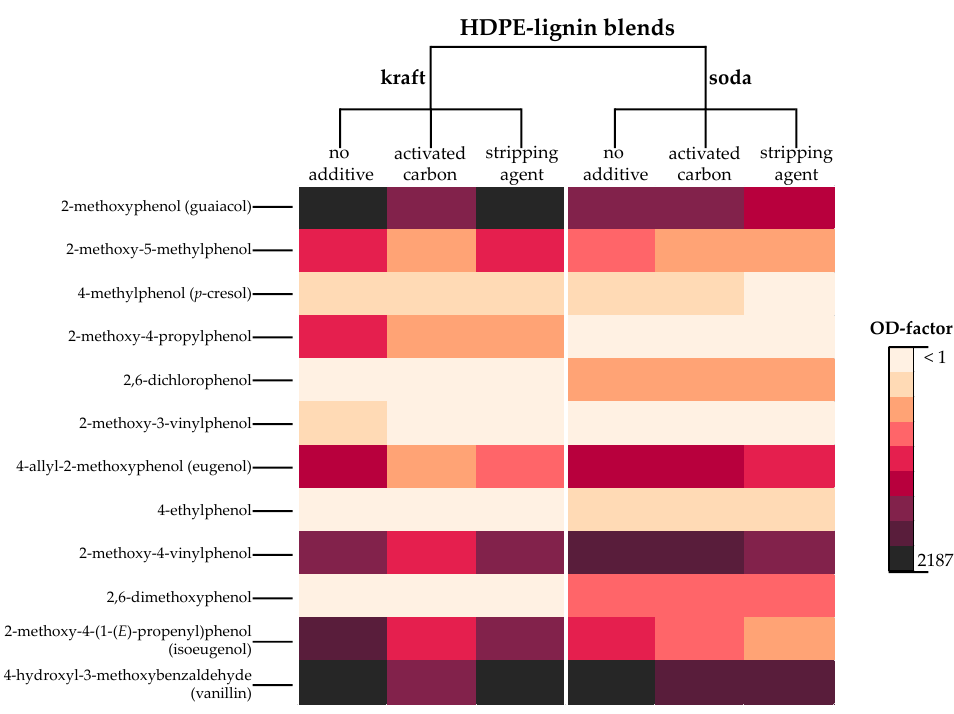
Figure 3. Color-illustrated differences in OD-factors of phenolic odorants detected in untreated and treated kraft and soda HDPE-lignin blends.